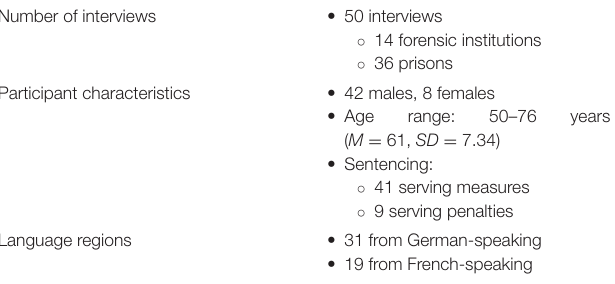
TABLE 2 | Study participant